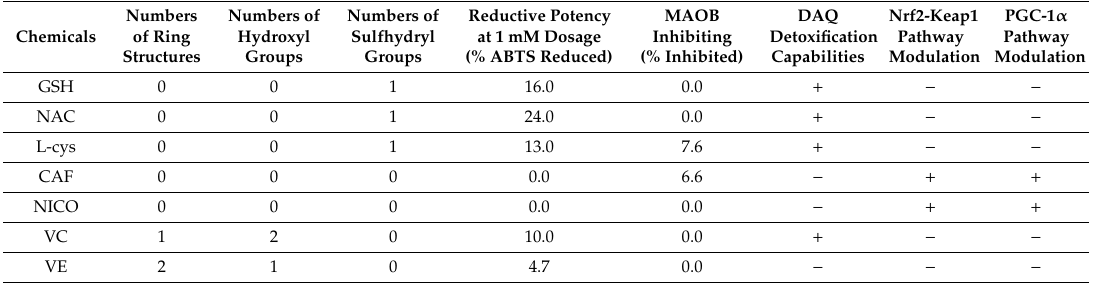
Table 1. Structure features and identified functions of tea polyphenols and other